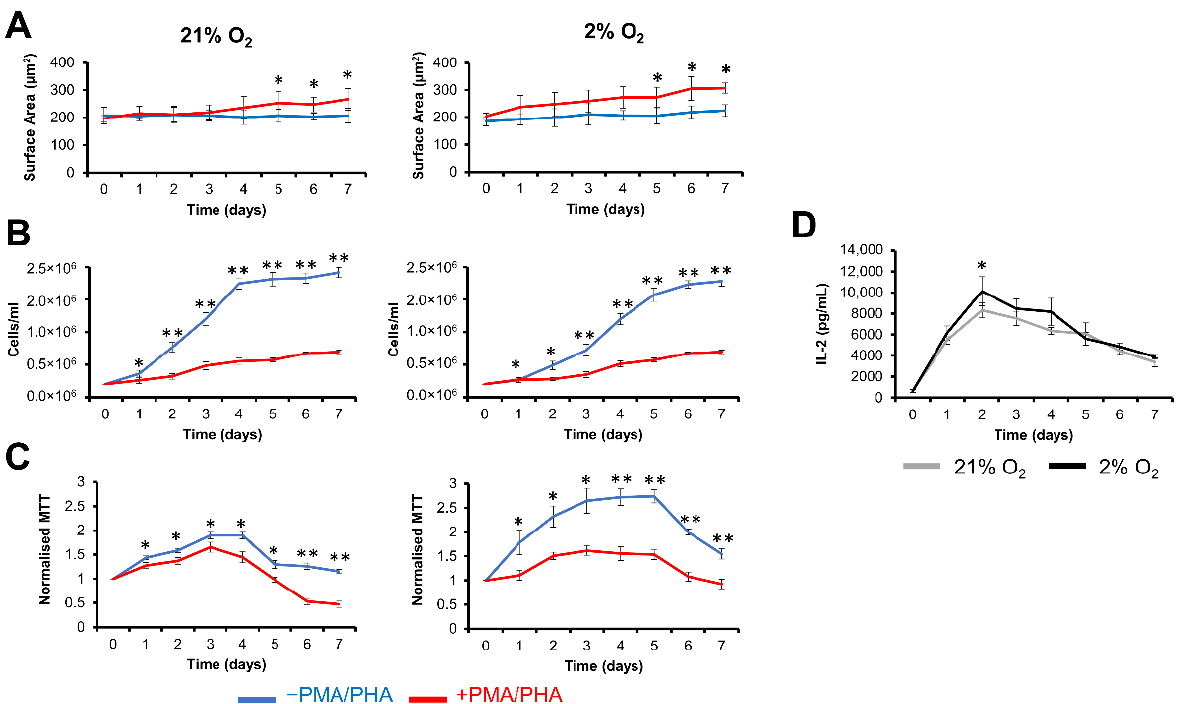
Figure 1. PMA/PHA stimulation results in suppression of proliferation and induction of polarisation. The proliferation and activation of Jurkat T cells were characterised in GM ± PMA/PHA in both air (21% O 2 ) and physoxia (2% O 2 ) over 7 days. ( A ) Surface area measurements (μm 2 ) of Jurkat T cells in GM ± PMA/PHA over a 7 day period. Data are expressed as mean ± SD of 3 spots for each slide ( n = 3). Statistical analysis consisting of a two-sample t-test was conducted to compare the two groups. ( B ) Proliferation was assessed using haemocytometer-based cell counting from 3 independent flasks ( n = 3). ( C ) Corresponding optical density (O.D.) values for metabolic MTT assays on three replicate samples ( n = 36). MTT assay values at each time point were normalised to day 0. ( D ) IL-2 concentration (pg/mL) in cell culture media in the presence of PMA/PHA inducers in both air and physoxia environments ( n = 9). Statistical analysis consisting of a two-sample t-test was conducted to compare the different groups. Data expressed as mean ± SD, * p < 0.05, ** p <